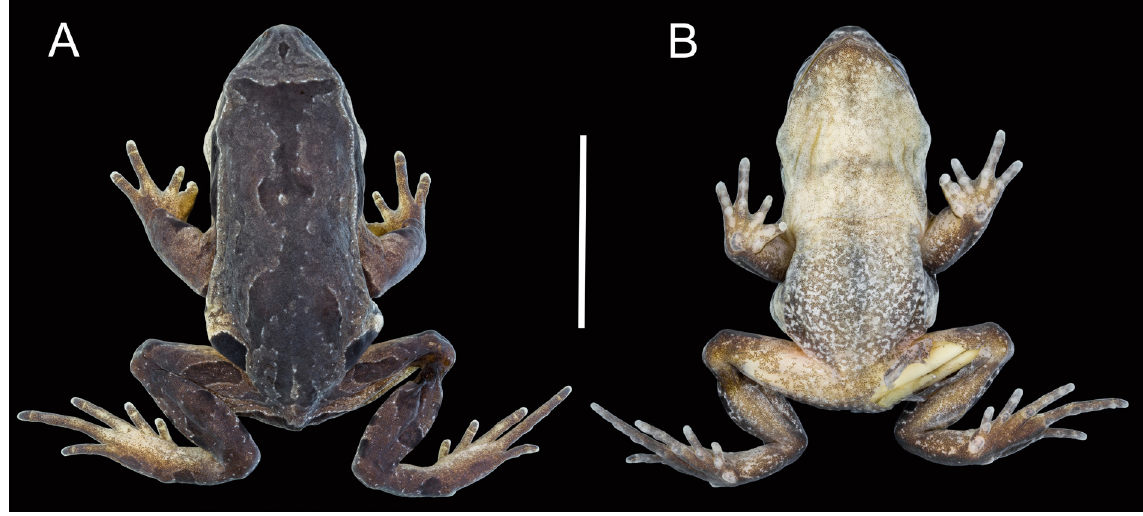
Fig. 1. Physalaemus araxa sp. nov., holotype, adult ♂, SVL 21 mm (ZUEC-AMP 24095). A . Dorsal view. B . Ventral view. Scale bar = 5